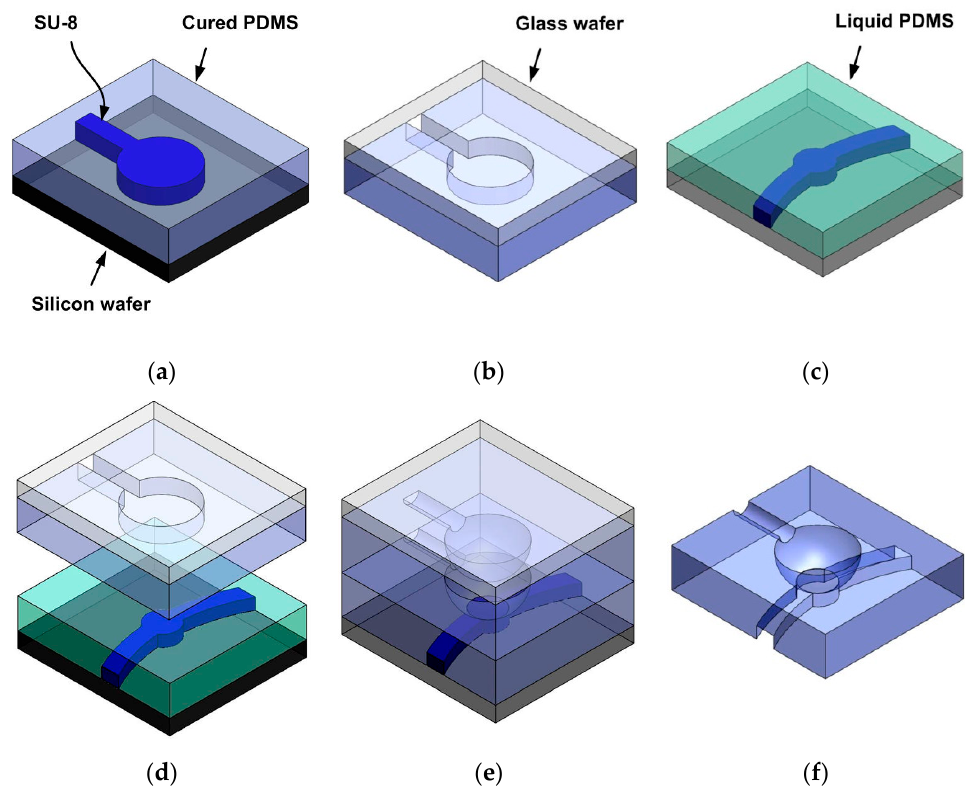
Figure 3. Fabrication of the three-dimensional (3D) fluidic network. ( a ) Replica molding of the curved microfluidic chamber and channel, ( b ) plasma bonding of the cured polydimethylsiloxane (PDMS) layer to a glass wafer, ( c ) pouring of liquid PDMS into an SU-8 mold to form the interconnection channel, ( d ) alignment of the bonded structure and an SU-8 mold, ( e ) replication via thermal curing at 130 °C for 30 min, ( f ) removal of the thermally activated structure and the SU-8 mold.